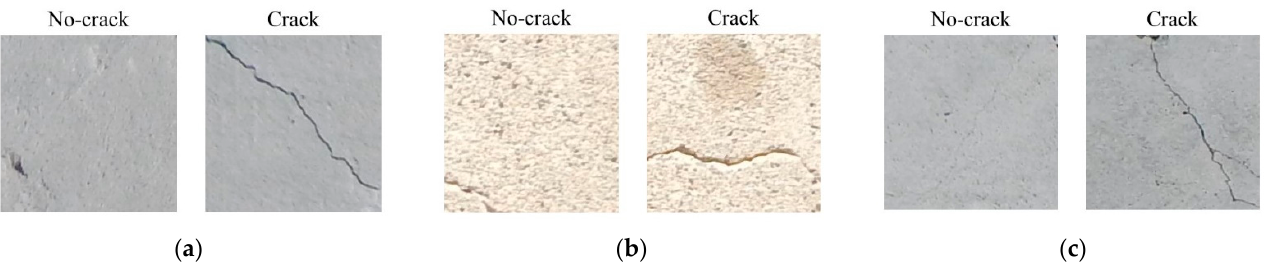
Figure 9. Examples of cross-dataset images: ( a ) bridge-decks; ( b ) pavements; ( c ) walls.